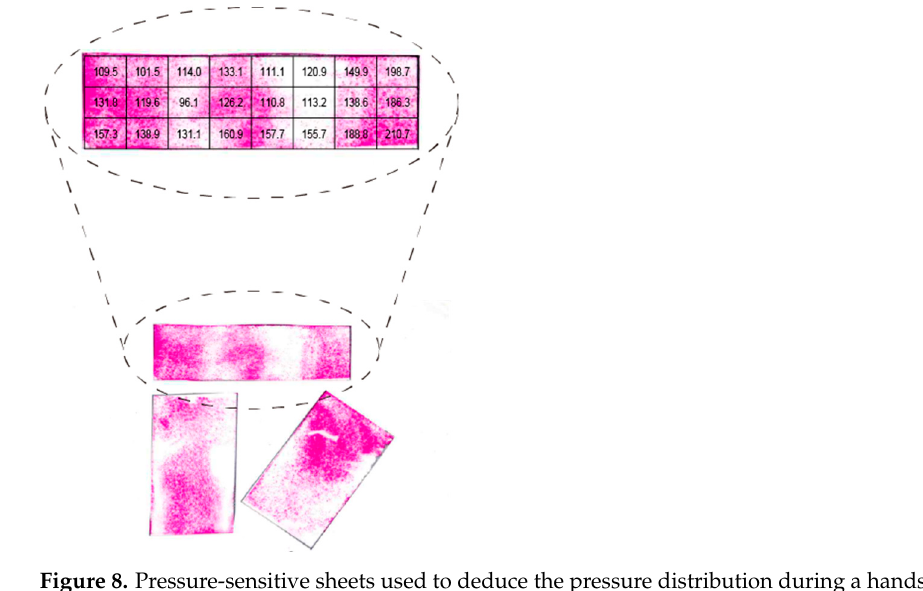
Figure 8. Pressure-sensitive sheets used to deduce the pressure distribution during a handshake. The quantified color intensity represents the pressure distribution in the grid at position I.